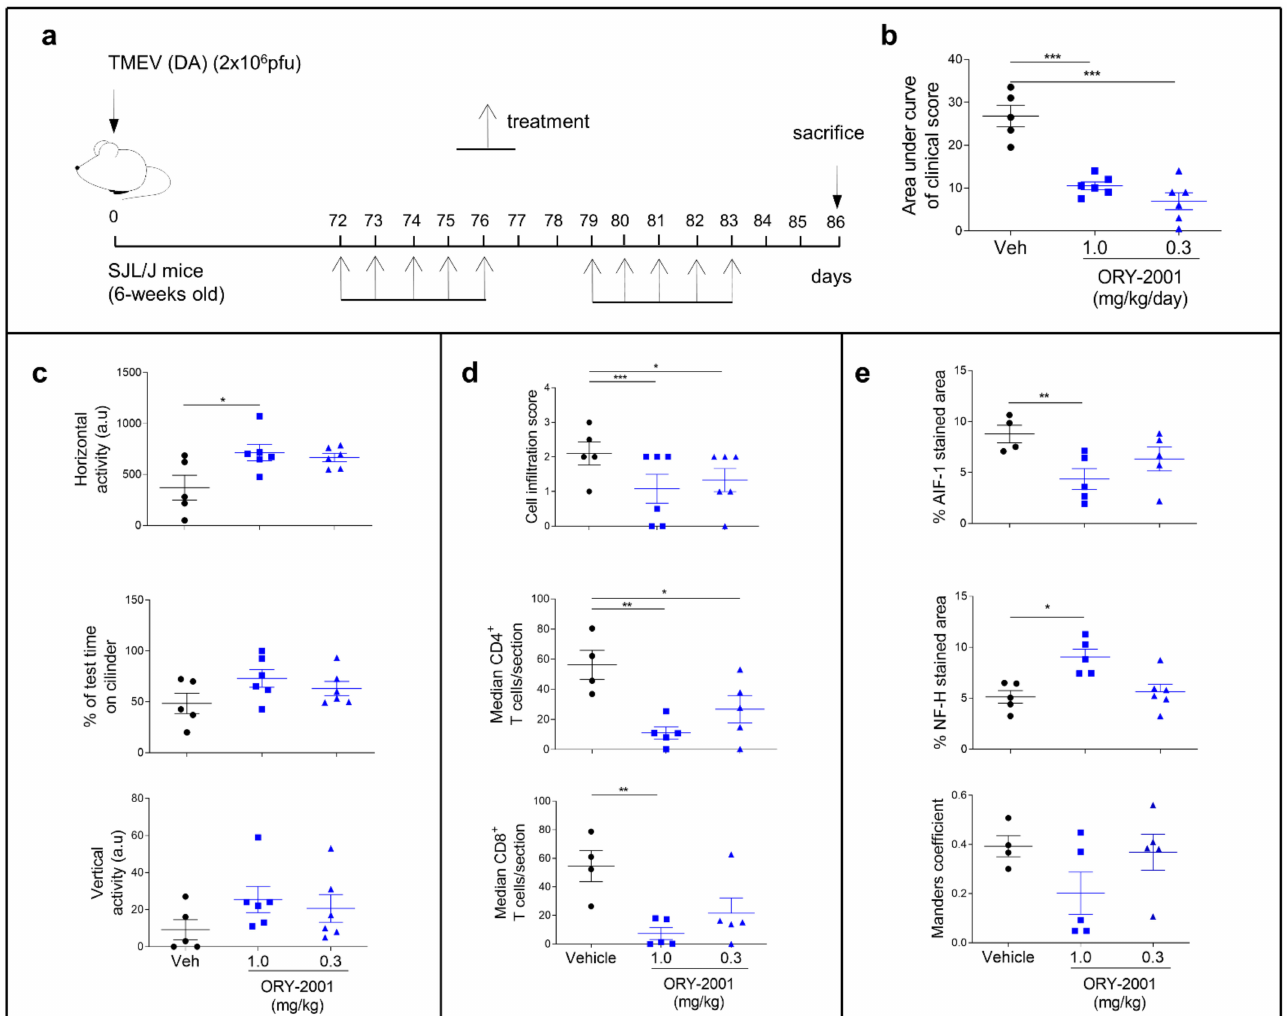
Figure 4. Therapeutic effects of ORY-2001 in the Theiler model. ( a ) Susceptible mice were infected with Daniel’s strain (DA) of TMEV into the cerebral parenchyma and treated orally with ORY-2001 (two different concentrations: 1.0 and 3.0 mg/kg) for two weeks following the onset of symptoms (72 days post-infection); ( b ) Clinical score was evaluated as the area under curve; ( c ) Motor func- tion was analyzed by the horizontal and vertical activity (HACTV and VACTV, respectively) in the activity cage test and coordination through the rotarod test. Histopathological analyses were performed to examine immune infiltration ( d ) and neuroinflammation ( e ); ( d ) Immune cell infiltra- tion score (upper graph) was determined, and the specific CD 4+ and CD 8+ T cells (medium and lower graph, respectively) were quantified in randomly selected sections of spinal cords from ve- hicle and ORY-2001-treated TMEV-infected mice; ( e ) Microglial activation analysis (upper graph, represented by the mean of the percentage of AIF-1 stained area), axonal integrity (medium graph, represented by the mean of the percentage of Neurofilament H positive area), and astroglial activation (lower graph, represents the mean of the Manders coefficient between Vimentin and GFAP staining) were performed on 6–12 images/mice from the ventral horn of spinal cord and data represents the mean of the percentage of respective staining in the cervical and thoracic regions of each animal. N = 4–6 mice/group; n = 4–6 spinal cord sections/mice. * p < 0.05, ** p < 0.01, *** p < 0.0005 be- tween vehicle and ORY-2001. Data are the mean ± SEM with dots representing individual values of biologically independent